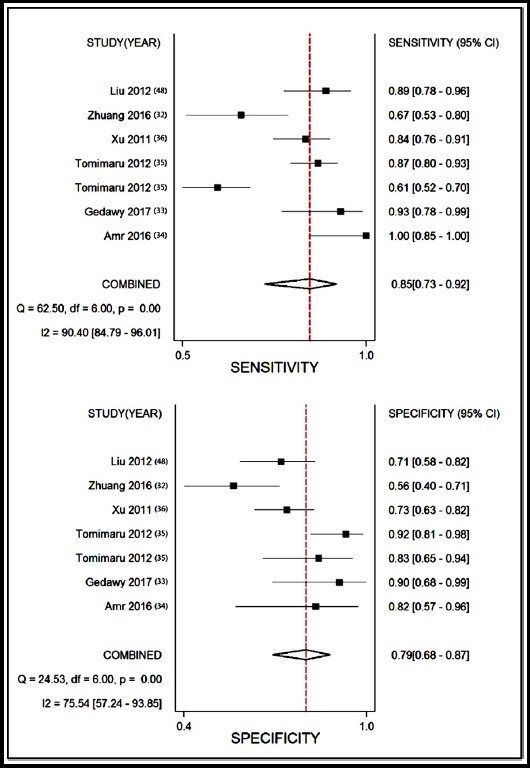
Sensitivity and specificity of circulating miR-21 for diagnosis of HCC.